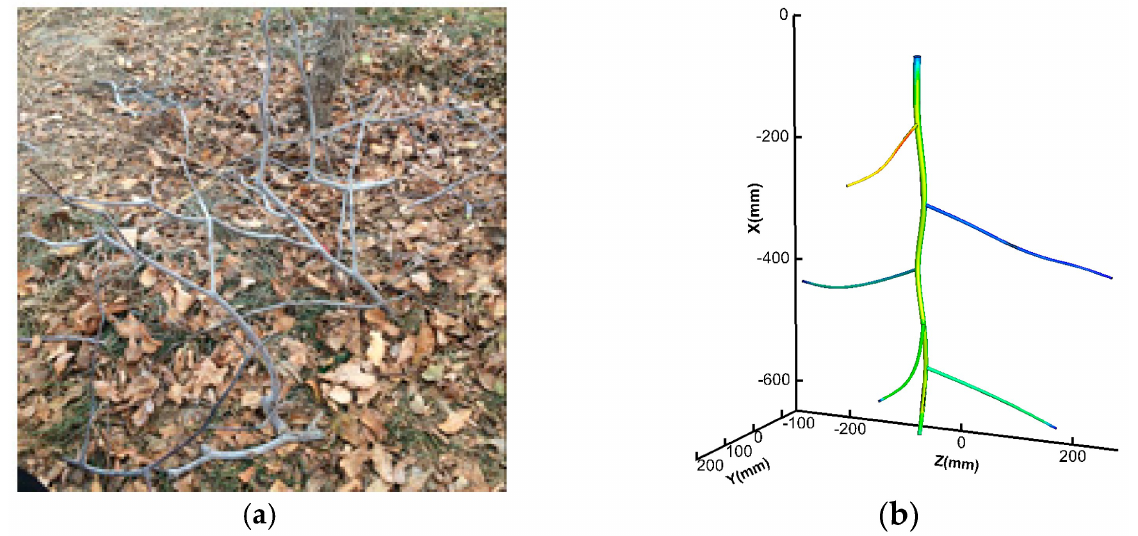
Figure 1. Jujube branch model. ( a ) Physical map of jujube branches to be picked. ( b ) Single jujube branch numerical model.